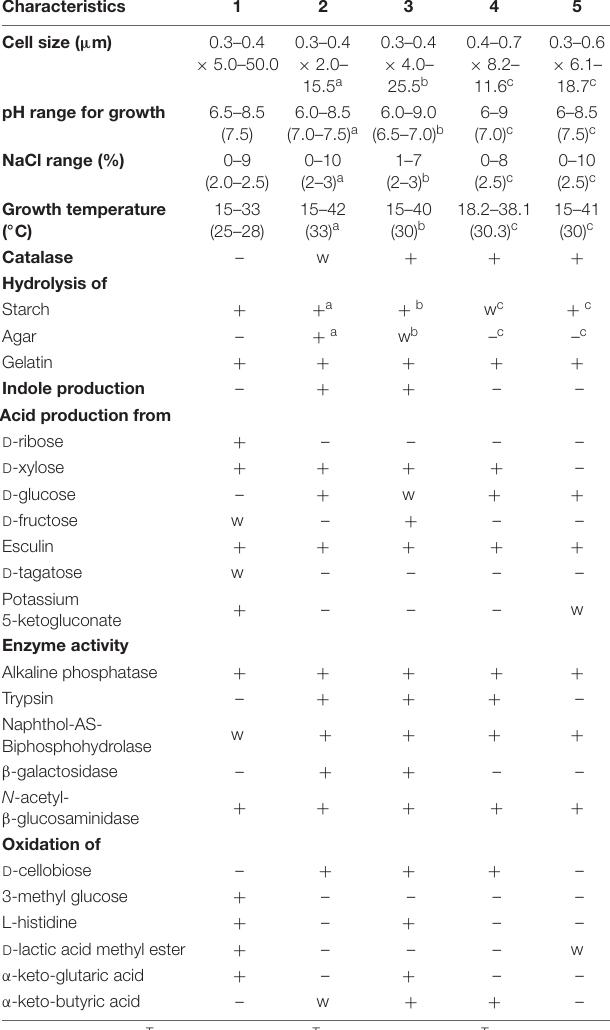
TABLE 1 | Differential phenotypic characteristics of strain N1Y132 T and the related Carboxylicivirga species.